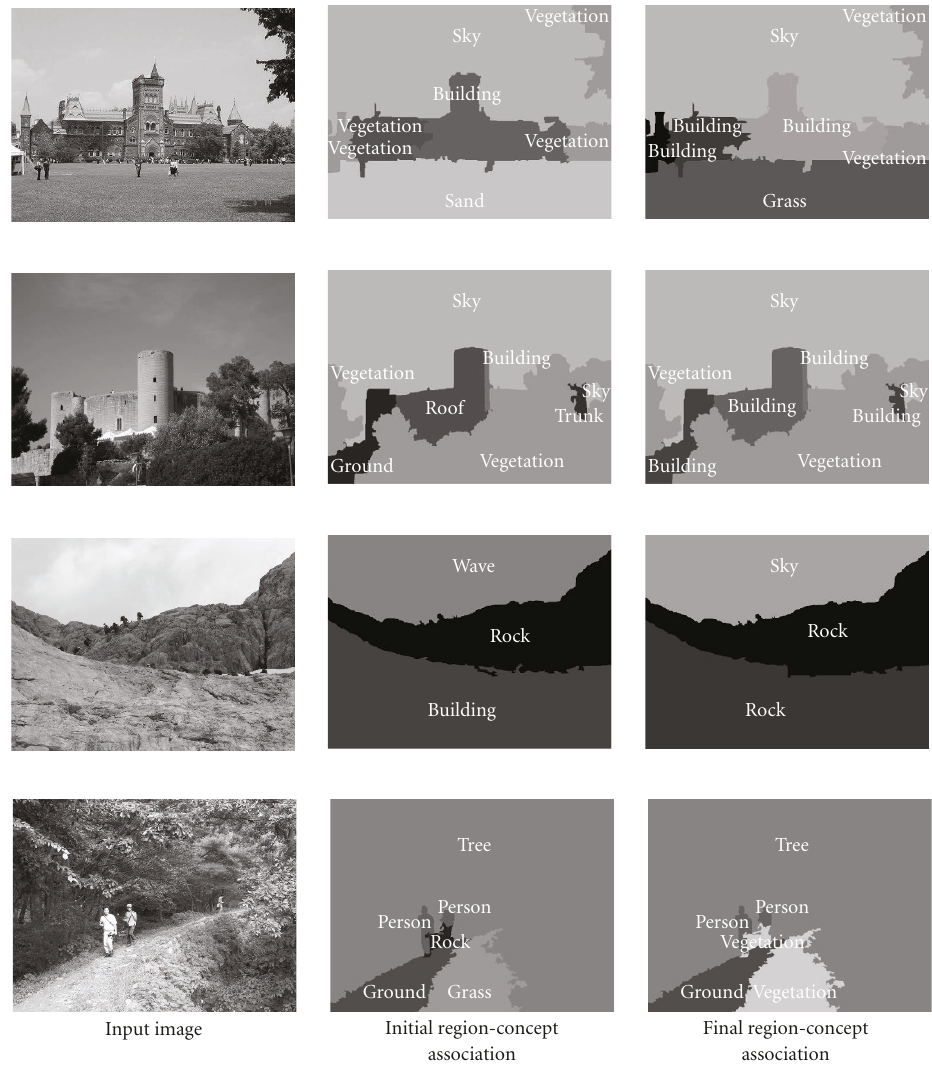
Figure 7: Indicative region-concept association